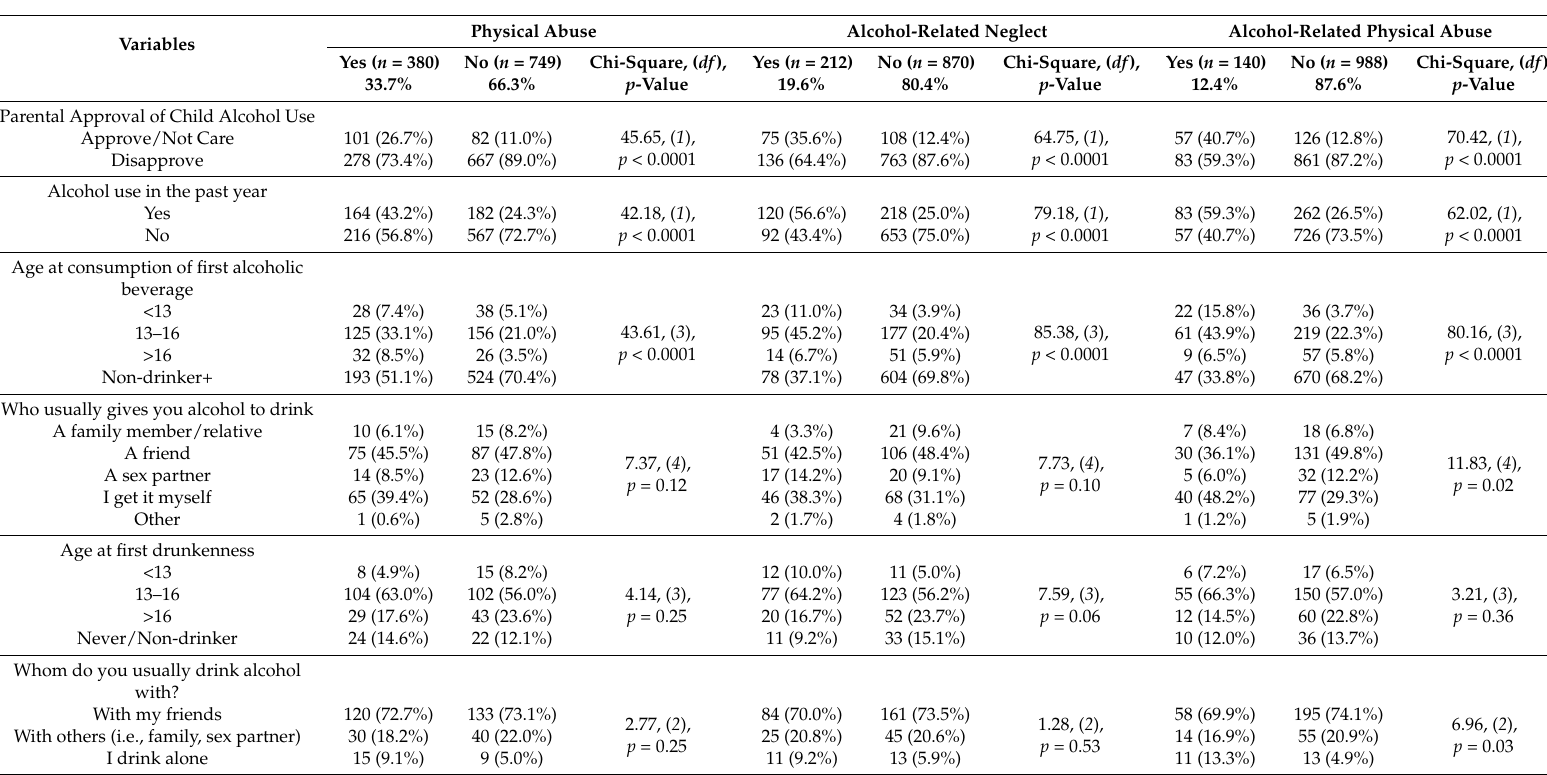
Table 2. Alcohol use perceptions, behaviors and help-seeking among youth living in the slums of Kampala reporting any physical abuse, alcohol-related neglect or alcohol-related physical abuse by their parents, ( n =